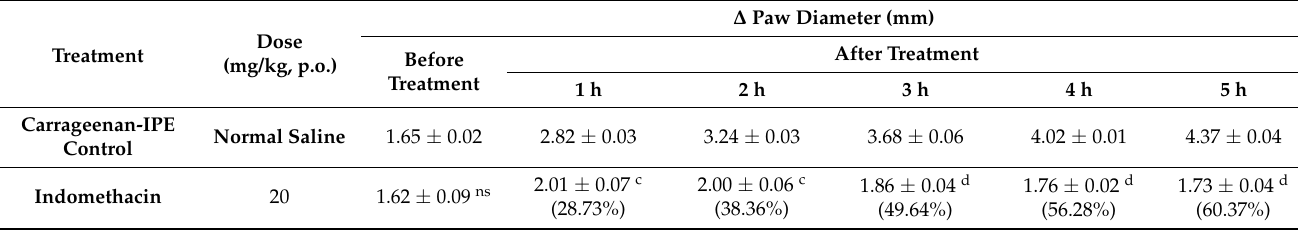
Table 4. Anti-inflammatory activity of R. tuberculata polar extracts and indomethacin on Carrageenan- induced paw edema in mice. Dose Treatment (mg/kg,